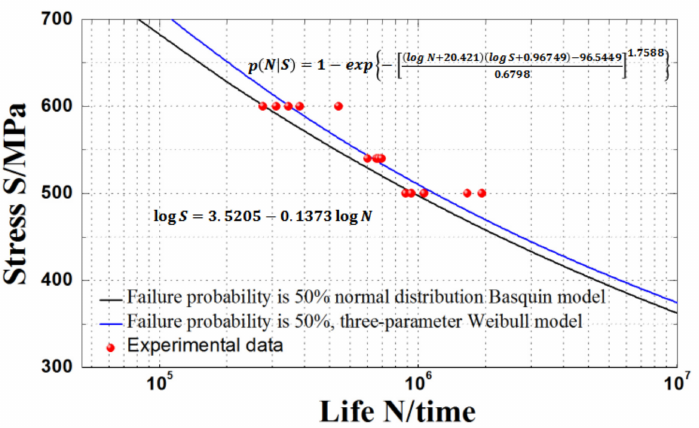
Figure 5. Comparison of S - N curve fitting results of HY-type ultra-high strength sucker rod obtained from the two